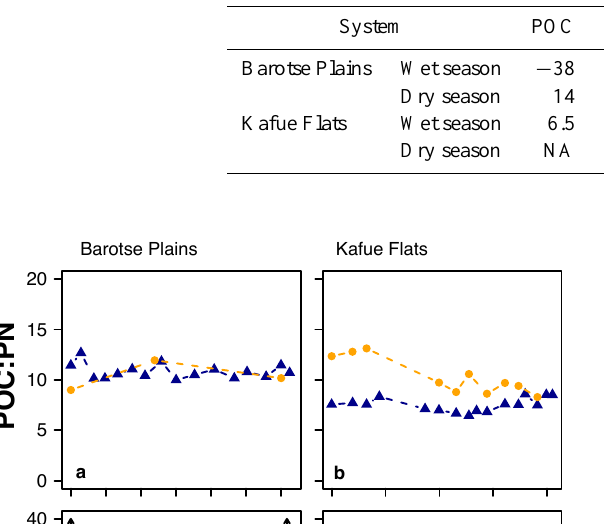
Table 1. Net export (in tons of C per day and tons of N per day), calculated as the difference between loads at the downstream and upstream ends of the respective floodplain, from the two floodplains during wet and dry seasons. Positive numbers indicate that the floodplain acted as a source (export), negative numbers indicate the floodplain acting as a sink (retention). POC and PN export from the Kafue Flats during the dry season could not be estimated due to a lack of measurements at downstream locations.